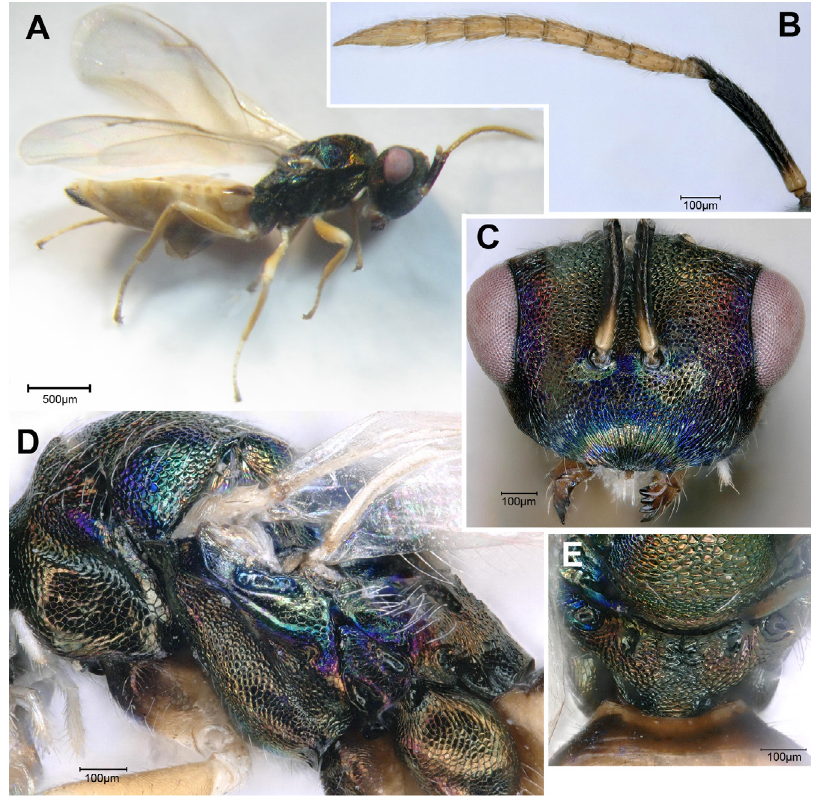
Fig. 11 . Homoporus febriculosus (Girault, 1917), female. A . Lateral view. B . Antenna. C . Head in frontal view. D . Metasoma in lateral view. E . Head in dorsal